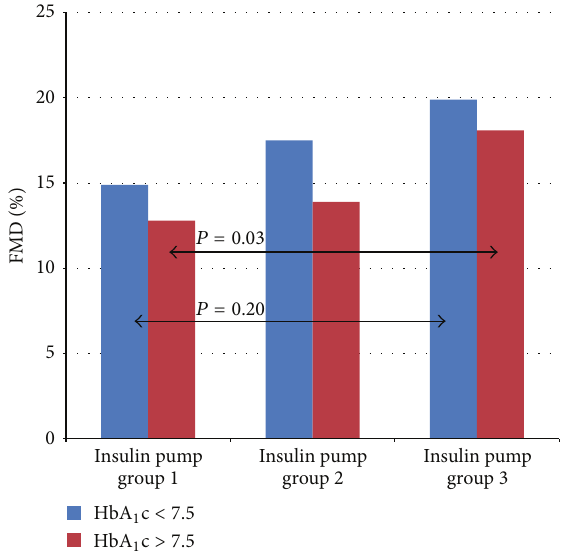
Figure 6: A change in FMD in the groups depending on the initial value of HbA 1 c < 7.5% and > 7.5% (1—before CSII, 2—after 3 months of CSII, and 3—after 6 months of